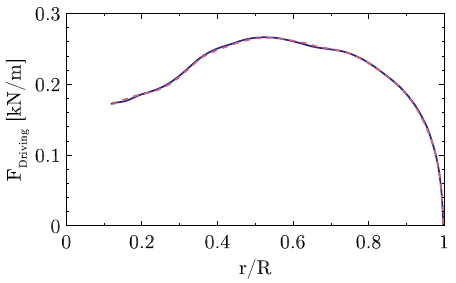
Figure 6. Influence of the grid resolution on the sectional driving force. Standard medium mesh (dashed), refined grid